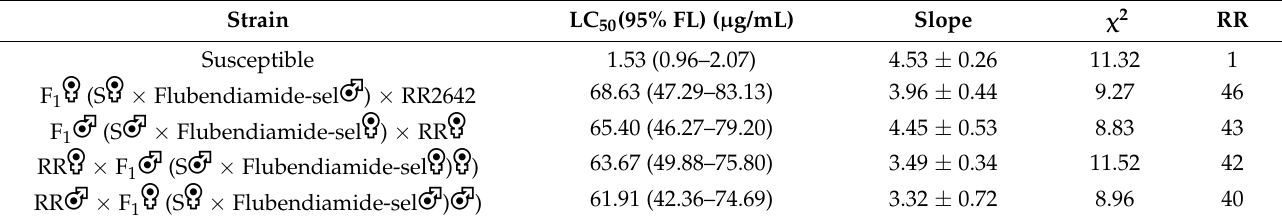
Resistance will be considered significantly different if LC 50 will not overlap on 95% Fiducial Limit and non-significant if LC 50 will overlap on 95% Fiducial Limit. ♀ and ♂ represent female and male T. absoluta , respectively. The same as followed. Table 5. F 1 progeny backcross with resistant parents of Tuta absoluta. Table 6. Monogenic model for actual and expected mortality of Tuta absoluta.